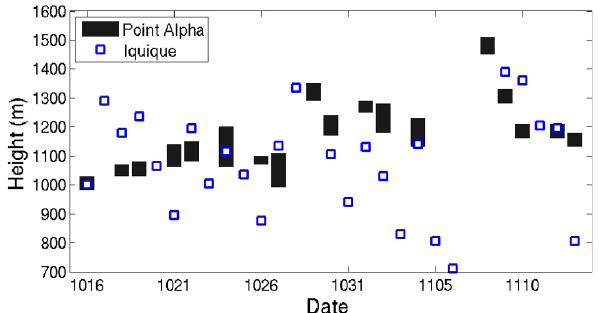
Fig. 9. Synthesis of the inversion level at Point Alpha from flight data, and at Iquique from radiosonde data. The open squares indi- cate the early morning soundings ( ∼ 07:00UTC), and the black bar shows the inversion zone for each